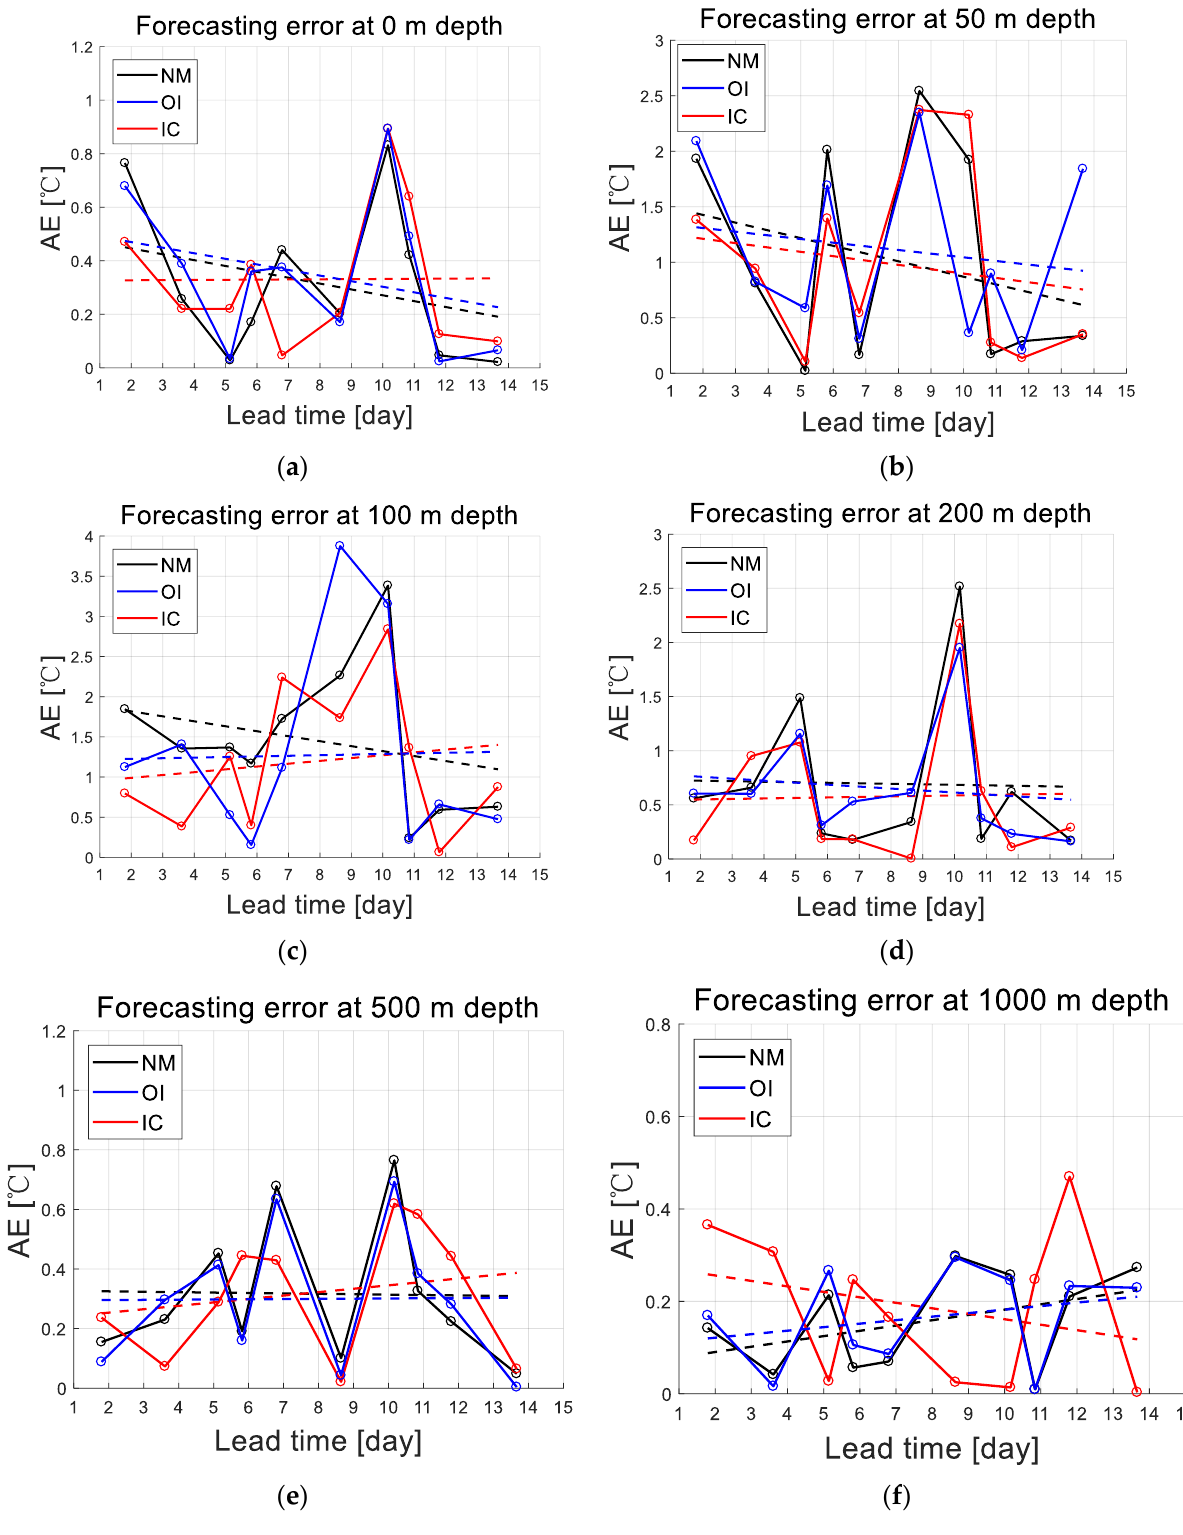
Figure 8. Temperature forecasting error of Experiment 4. ( a ) 0 m; ( b ) 50 m; ( c ) 100 m; ( d ) 200 m; ( e ) 500 m; ( f ) 1000 m. The black line is the forecasting error of the original numerical model (NM), the blue line is the forecasting error of the OI, the red line is the forecasting error of the IC and the dashed line is the error regression line.